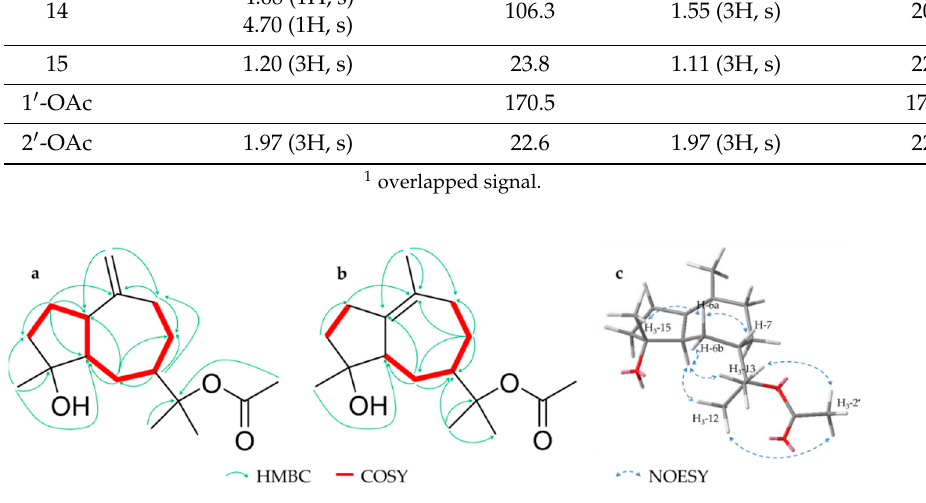
Figure 4. Key HMBC and COSY correlations for compound 4 ( a ) and 5 ( b ) as well as relevant NOESY signals of compound 5 ( c ).